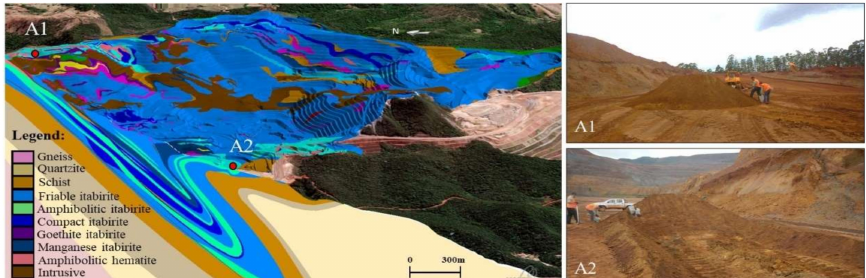
Figure 1. Geological section and map of Brucutu’s deposit, with the location of the two regions